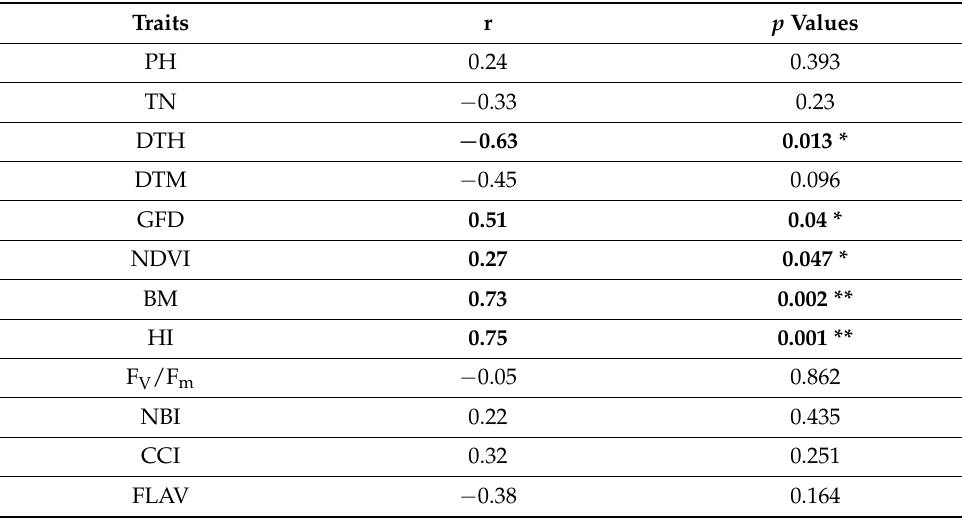
Table 4. Correlation coefficients of traits with grain